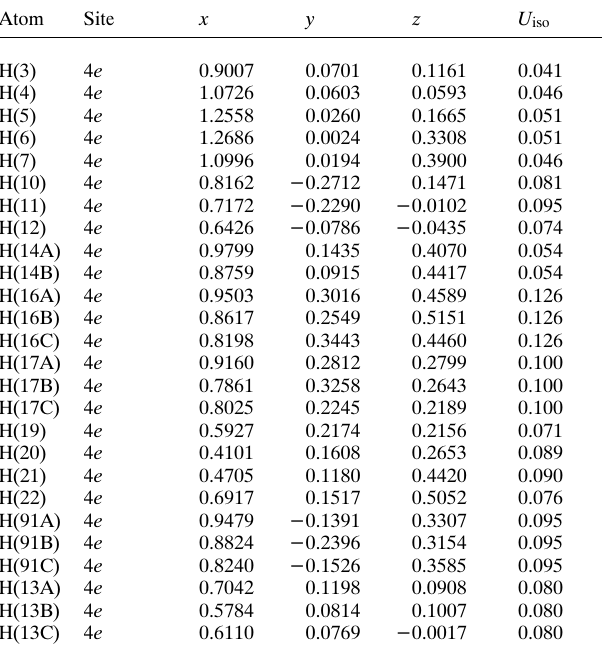
Table 2. Atomic coordinates and displacement parameters (in Å 2 )